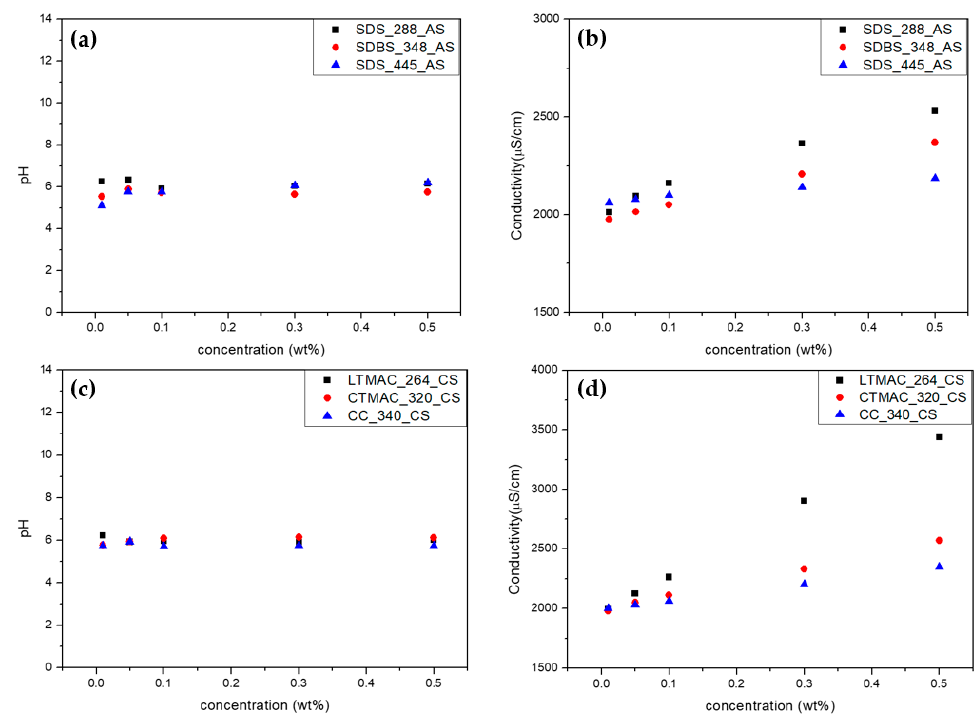
Figure 4. Variation of the pH and ionic conductivity of the solutions containing the foulants with various concentrations in 0.017 M NaCl: ( a ) pH and ( b ) ion conductivity of the anion foulant solutions and ( c ) pH and ( d ) ion conductivity of the cation foulant solutions.